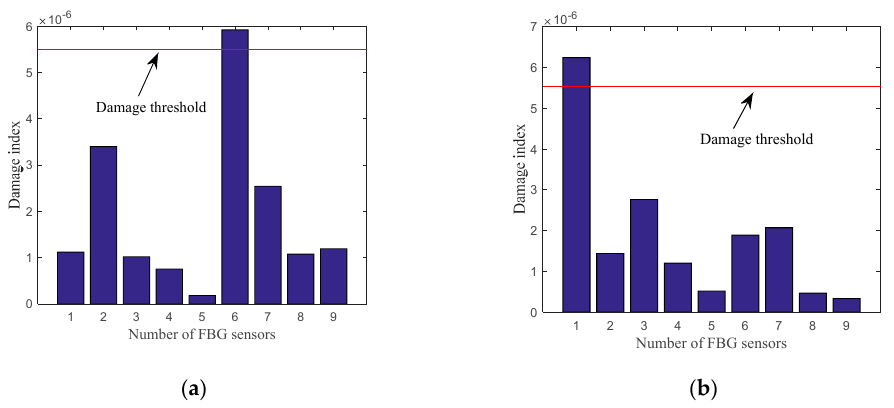
Figure 10. Damage indexes of ( a ) plate B and ( b ) plate C.